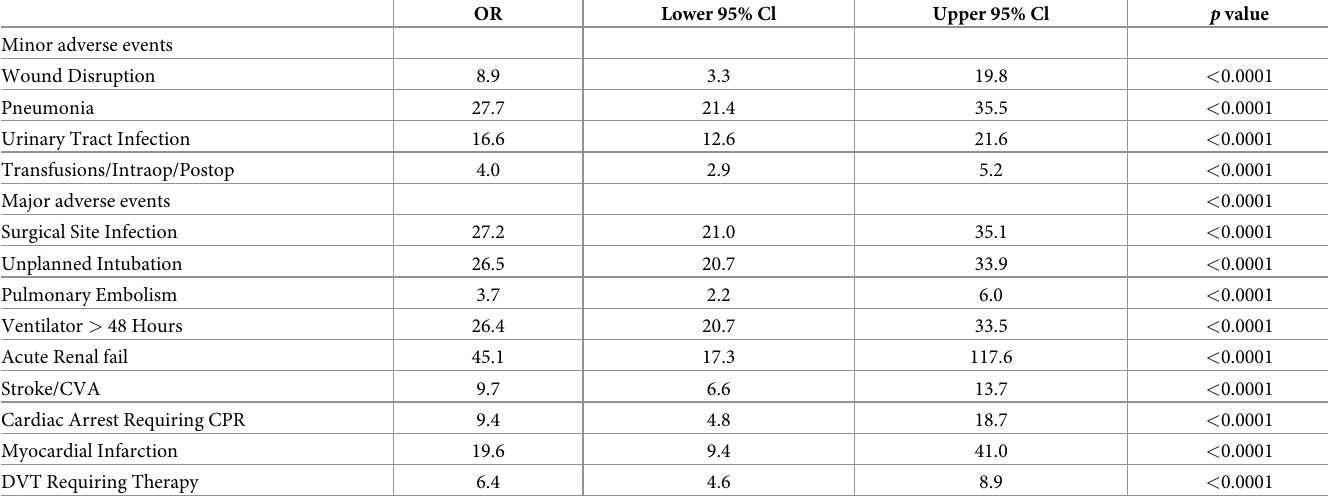
Table 5. Post operative complications associated with